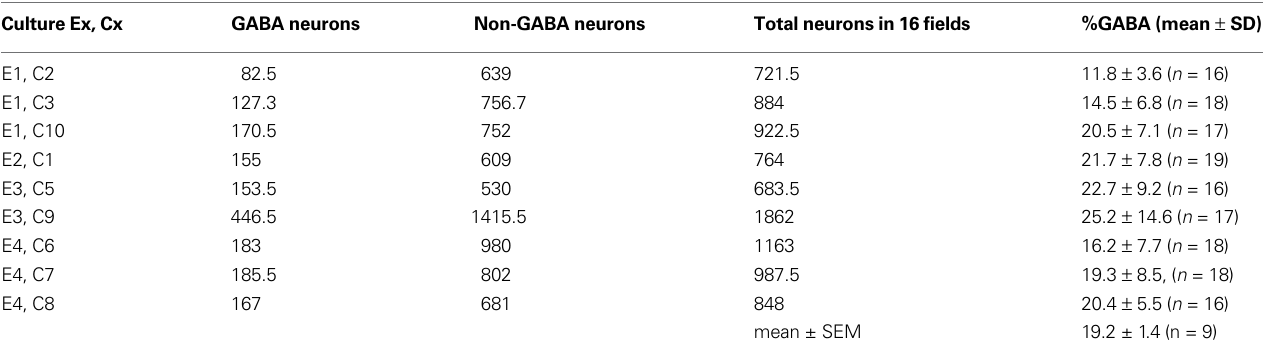
Table 1 | Results from counting GABA immunostained neurons and non-GABA neurons in cultures (Cx, n = 9) obtained from four experimental sets (mice, Ex). In each culture at least 16 fi elds were